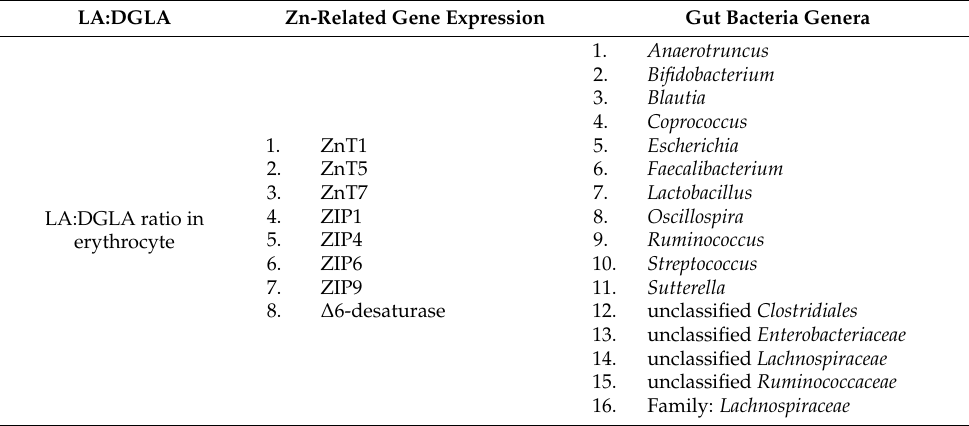
Table 4. Potential predictors of Zn status used in ZSI development We currently have a training sample of n = 59 Gallus gallus and a total of 25 potential predictors for Zn status, including LA:DGLA, eight genes, and 16 bacteria genera.